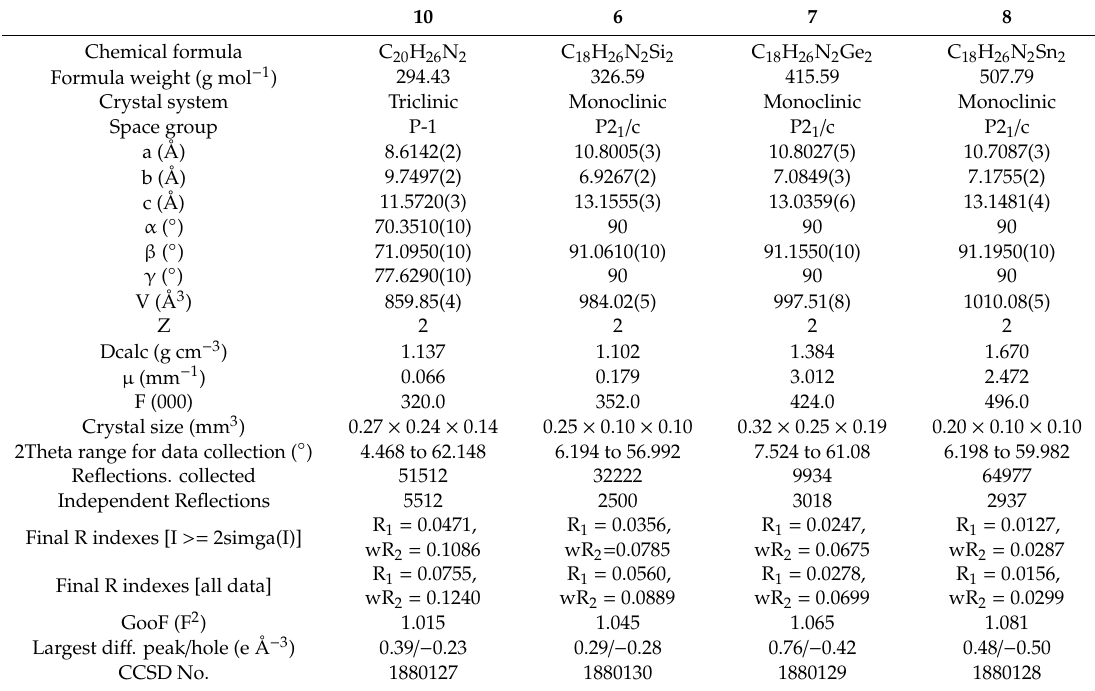
Table A1. Crystal data and structure refinement for azobenzenes 10 , 6 – 8 .